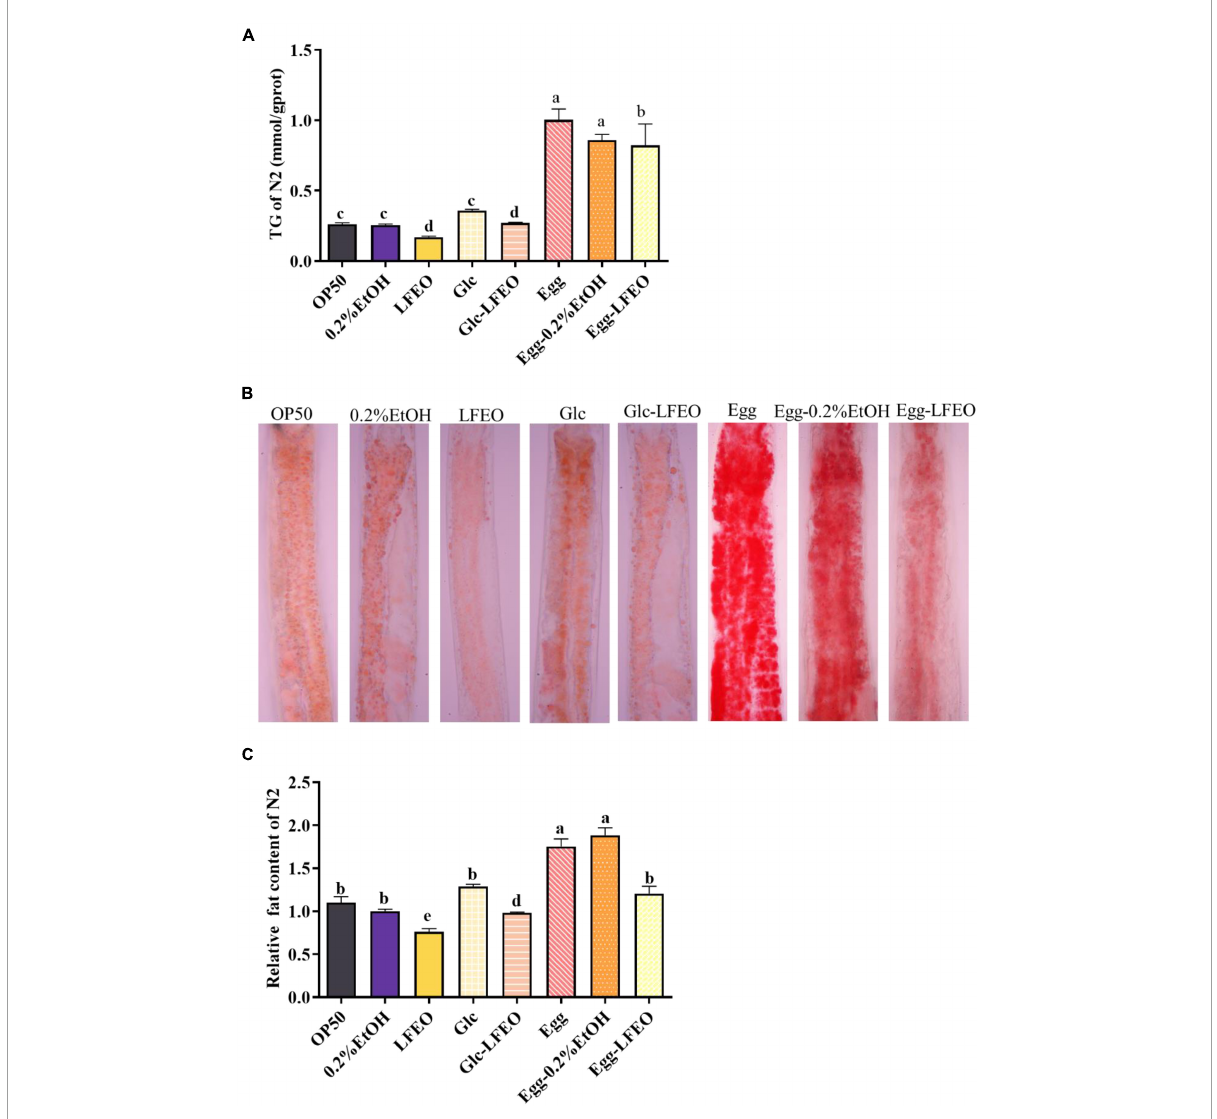
FIGURE3 Effect of litchi flower essential oil (LFEO) on reducing fat accumulation in normal and glucose diet, and high-fat diet C. elegans . (A) Triglyceride contents of C. elegans incubated with LFEO in normal, glucose-feeding, and egg yolk feeding worms (n = three biologically independent samples; one-way ANOVA with Bonferroni tests as post hoc comparison; different letters indicate a significant difference, p < 0.05). (B) The representative pictures of nematodes stained with ORO. (C) Using image J software to quantify the pictures of ORO staining to calculate relative fat quantification of the worms ( n ≥ 15 worms per group; one-way ANOVA with Bonferroni tests as post hoc comparison; different letters indicate a significant difference, p <